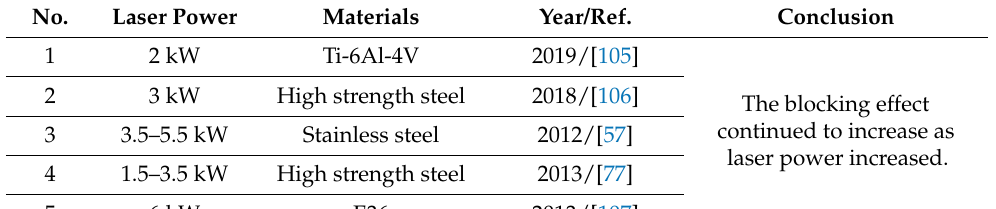
Table 5. The relation of laser power and blocking effect in this review.